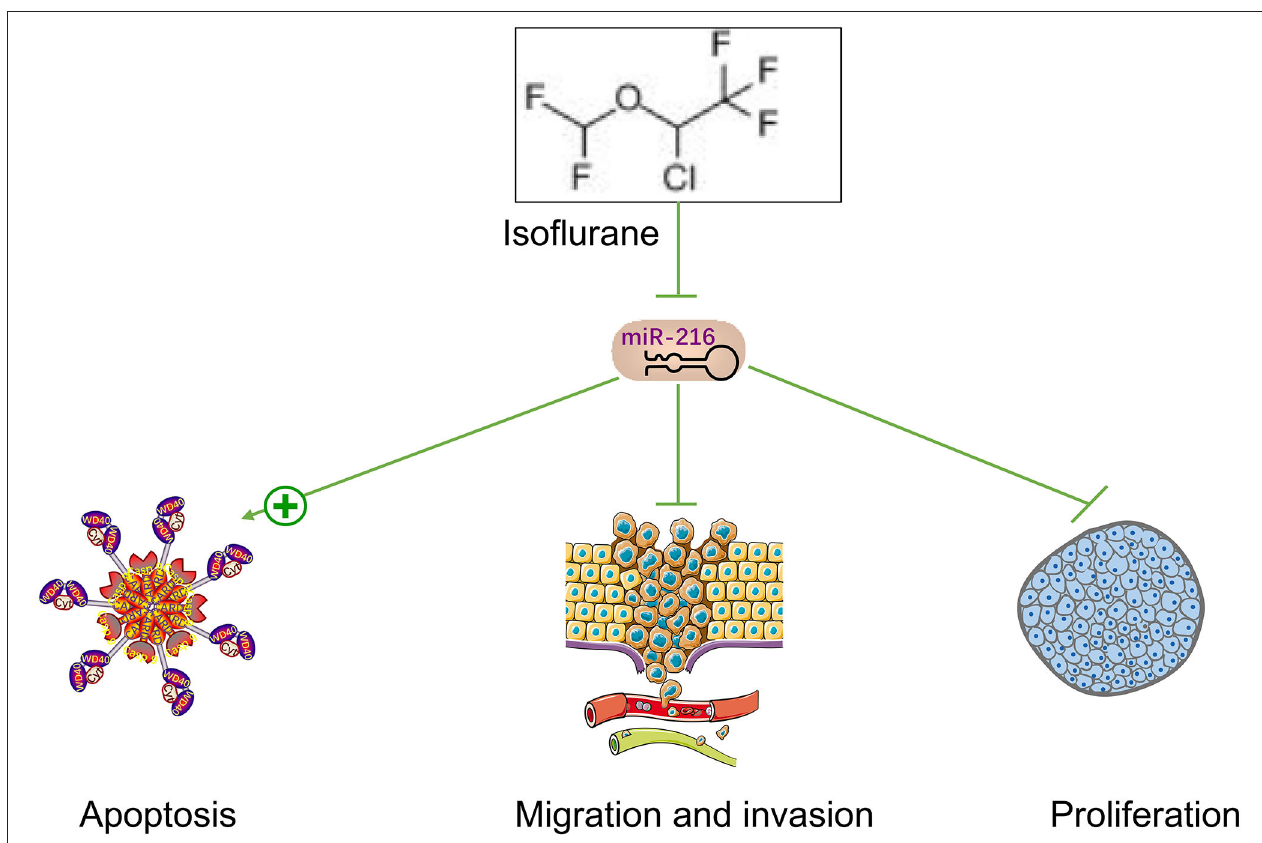
FIGURE 7 | The mechanism diagram of this